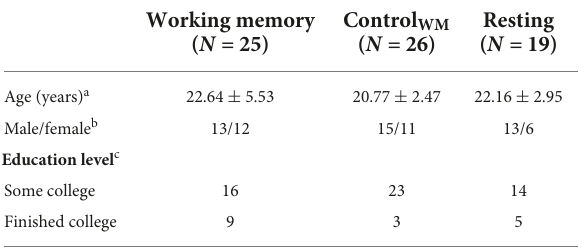
TABLE 2 Demographic data for experiment 2.